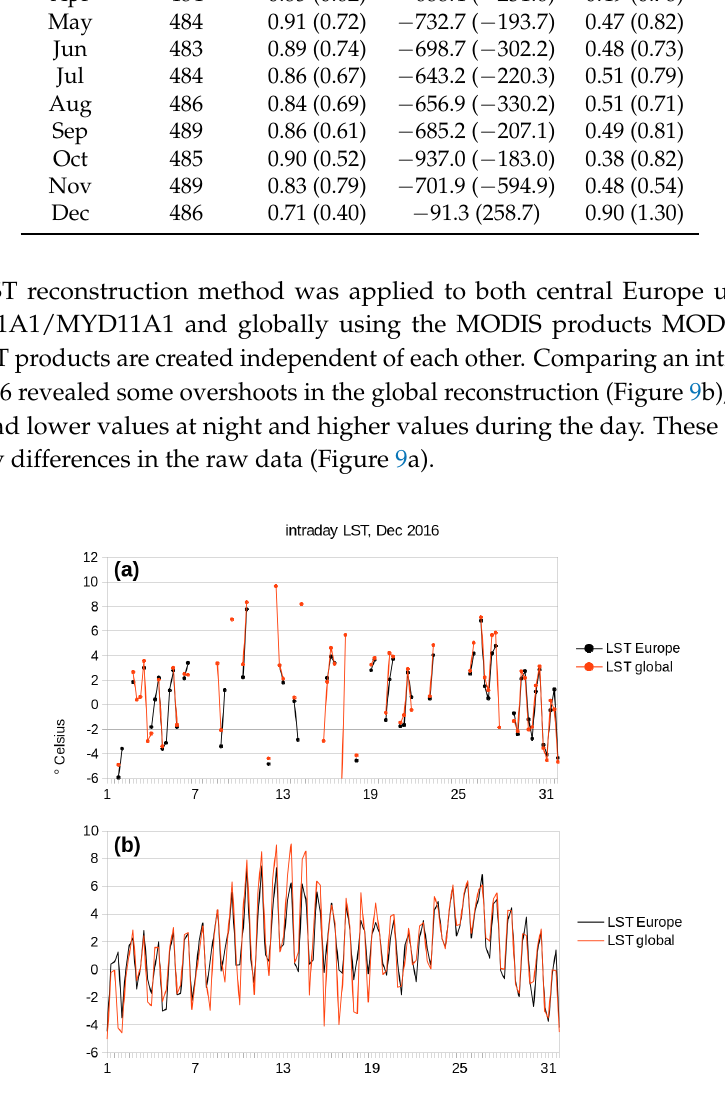
Figure 9. LST time series for Bonn, Germany, in December 2016, for central Europe (black) and globally (red) with: ( a ) original LST values; and ( b ) reconstructed LST values. Time steps per day correspond to MODIS overpass times: 01:30, 10:30, 13:30 and